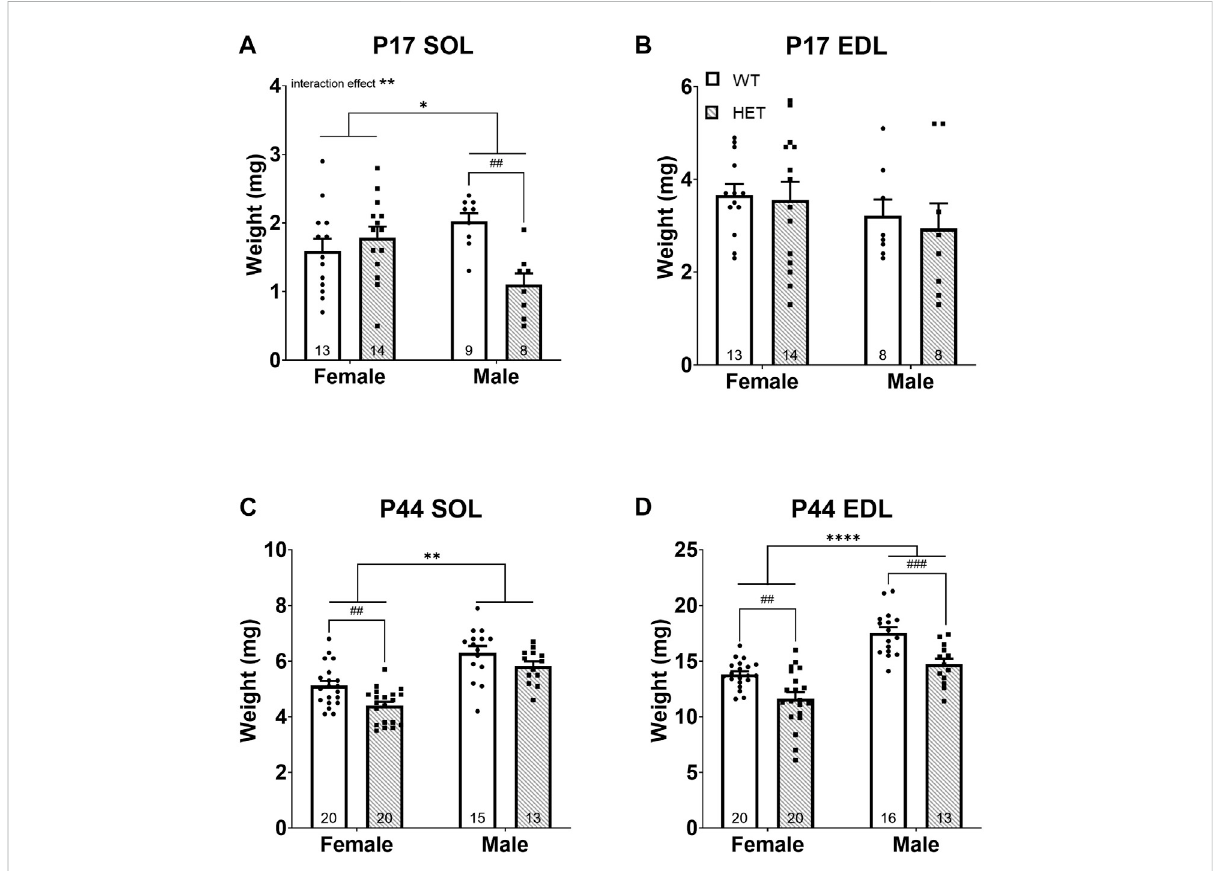
FIGURE 2 HET mice have decreased skeletal muscle weights (i.e., muscle mass). Skeletal muscles weight at ages P17 and P44 for SOL (A,C) and EDL (B,D) are shown. * p < 0.05; ** p < 0.01; **** p < 0.0001 (2-way ANOVA). ## p < 0.01; ### p < 0.001 (post hoc test; effect of genotype only). Error bars show ±SEM; number of biological replicates are shown within each